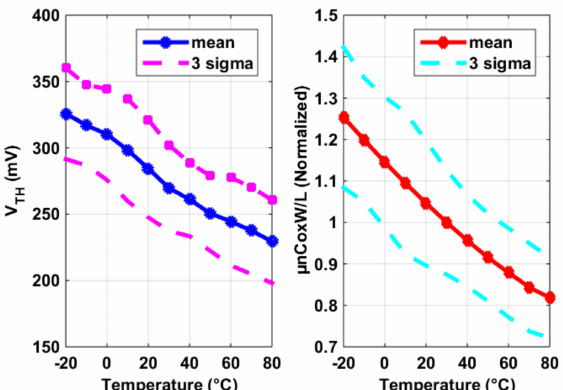
Figure 7. Extracted threshold voltage V TH ( left ) and µ n CoxW/L ( right ), from the measurement results of Figure 6.